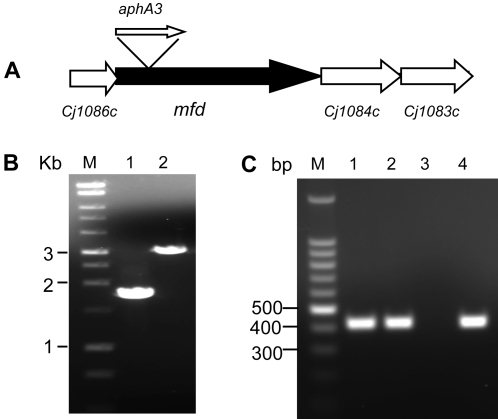
Insertional mutation of mfd and its impact on the transcription of cj1084c.(A) Diagram depicting the genomic organization of mfd and its flanking regions. ORFs and their directions of transcription are indicated by boxed arrows. The location of the inserted kanamycin resistance gene (aphA3) in mfd is indicated. (B) PCR confirmation of the aphA3 insertion into the mfd gene in JH01. Lane 1 shows the PCR product from 11168, while Lane 2 shows the PCR product of JH01. The primers used in the PCR were mfd-F2 and mfd-R2. Lane M contains 1 kb DNA size markers (Promega). (C) RT-PCR analysis of cj1084c expression in strains 11168 and JH01. The same amount of total RNA from 11168 (Lane 1) and JH01 (Lane 2 and 3) were used as template in the RT-PCR. Lanes 1 and 2 are normal RT-PCR reactions. Lane 3 is a RT-PCR reaction without reverse transcriptase (DNA-free control for the RNA preparation). In Lane 4, genomic DNA of 11168 was used as template (positive control for PCR).